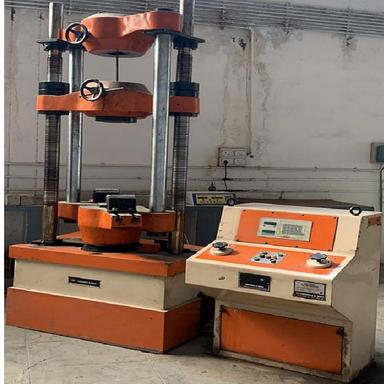
Universal Test Machine @ MJCET Campus.